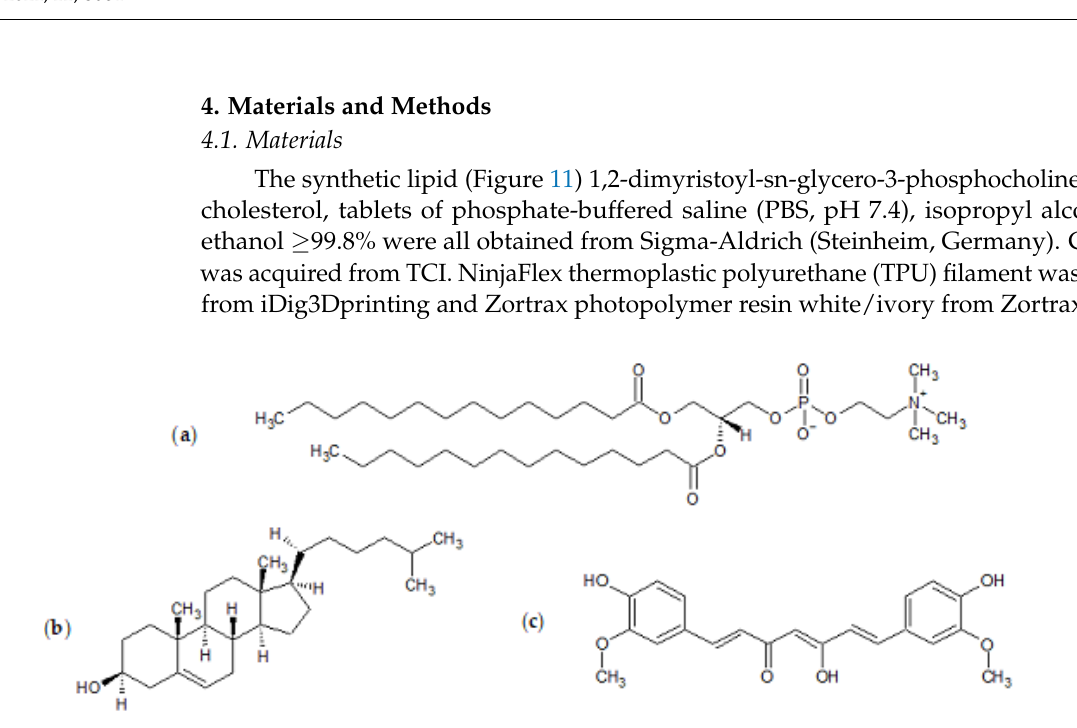
Figure 11. Chemical structures of ( a ) 1,2-dimyristoyl-sn-glycero-3-phosphocholine (DMPC), ( b ) cholesterol, and ( c ) curcu- min.